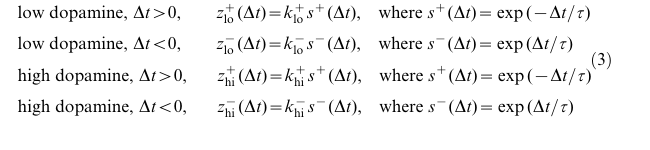
Table 1. Parameters for mixing STDP functions (kernels) and plasticity rules.